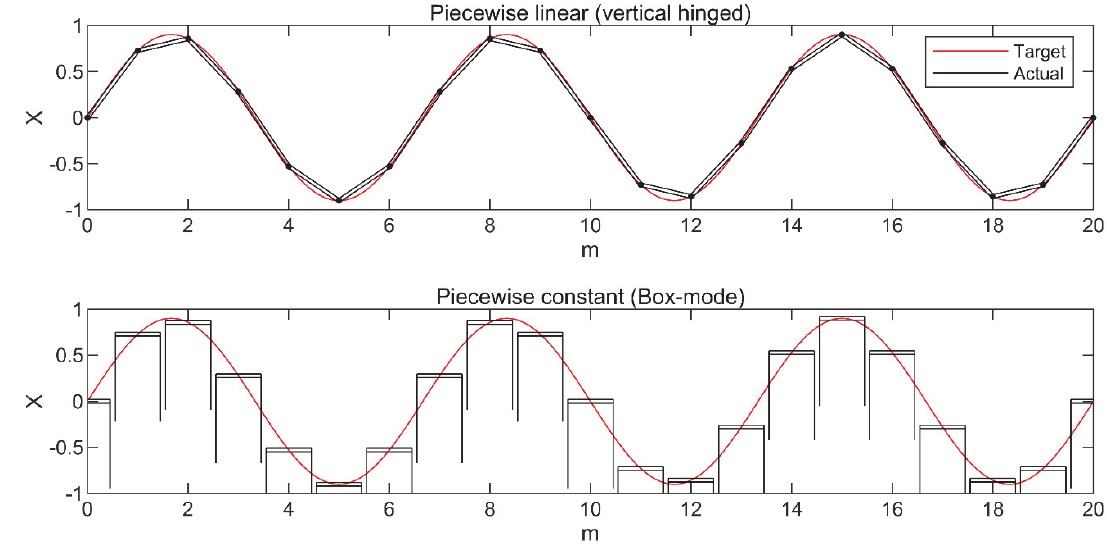
Figure 1. Example of vertical hinged and box-mode representation for a case with l p / L y = 0.15. m represents the actuator number. Actuators are thus located at y m = m l p ., where l p is the segment width.